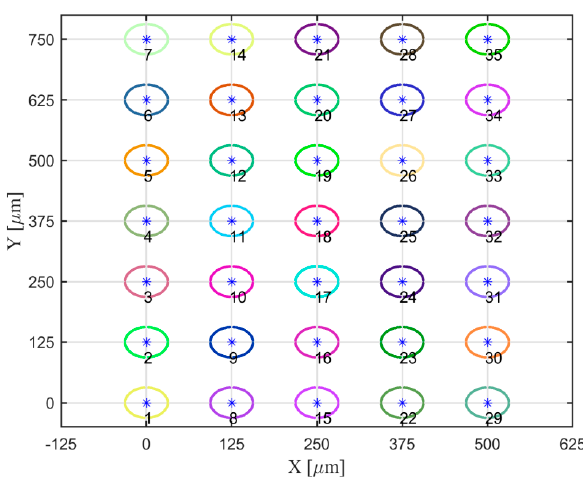
Figure 12. The separation of cylinders into individual point clouds.